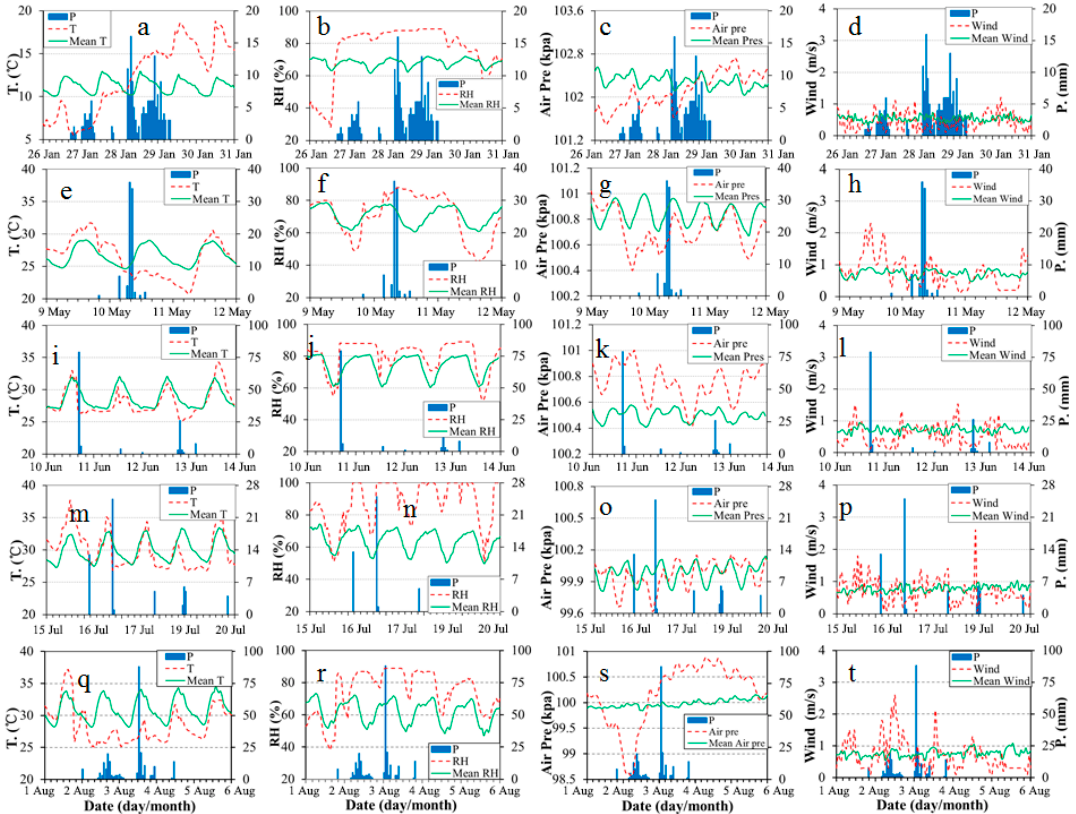
Figure 6. The fluctuations of air temperature, relative humidity, surface pressure, and wind speed at an urban station for a warm-front storm on 27–29 January 2016 ( a – d ), a cold-front storm on 9–11 May 2016 ( e – h ), a monsoon storm on 9–15 June 2016 ( i – l ), a convective storm on 14–20 July 2016 ( m – p ), and the typhoon Nida storm on 1–4 August 2016 ( q – t ). The green lines are the diurnal average during a two-week period centered at but excluded from the storm-affecting duration. This urban station (G3221) is located in the Tianhe District downtown of Guangzhou.